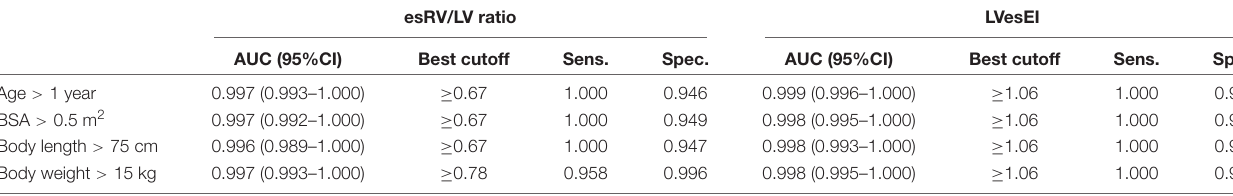
TABLE 2 | Differentiation of children with pulmonary hypertension (PH) from children without PH. esRV/LV ratio LVesEI AUC (95%CI) Best cutoff Sens.